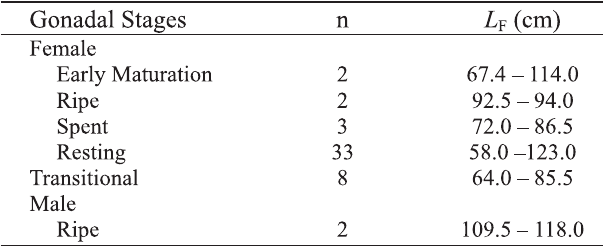
Table 2. Number of fishes (n) and range of fork length ( L centimeters, for gonadal stages.